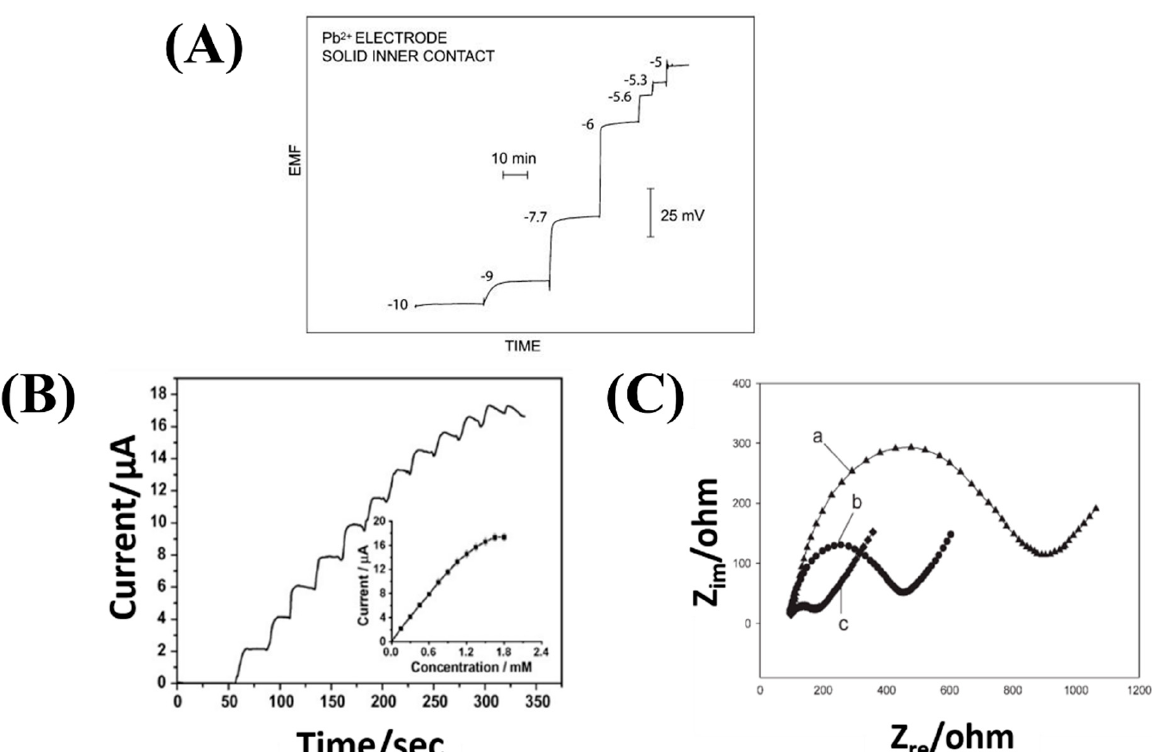
Figure 2. Measured response by three different transduction methods of electrochemical sensors: ( A ) Potentiometry (Potential at zero current—EMF electromotive force—vs. time under increasing volume of analyte—the numbers shown are logarithmic molar sample concentrations. Reproduced from [64] ( B ) Voltammetry (Current versus time under increasing volume of analyte) Reproduced from [68] ( C ) Electrochemical impedance spectroscopy (Nyquist plot: real impedance vs imaginary impedance for different of electrodes; a—Bare glassy carbon electrode (GCE) 1; b—CNTs/poly(1,2-